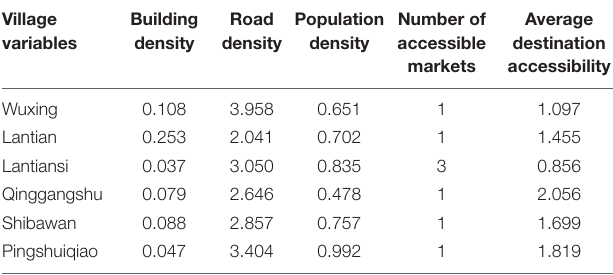
TABLE 3 | Socio-demographic variables. TABLE 4 | Built environment